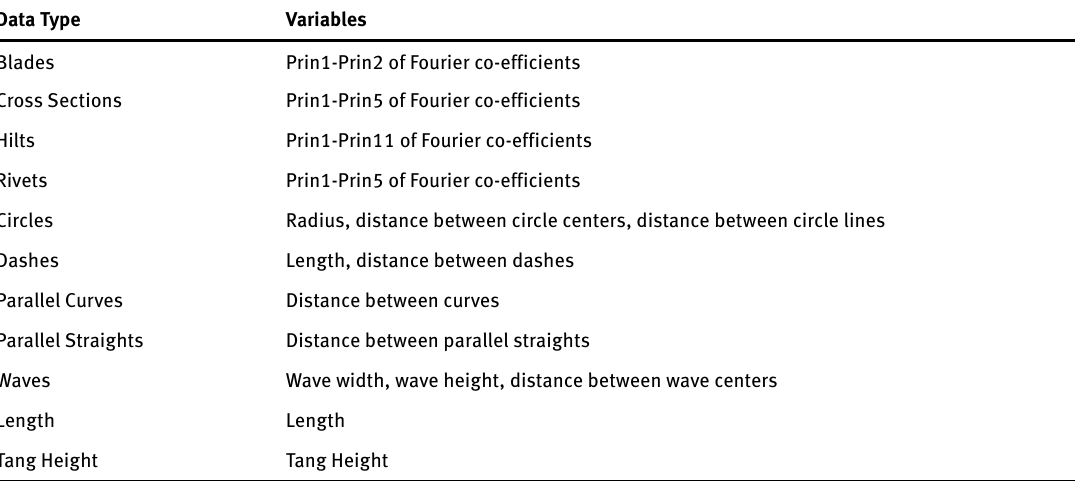
Table 1. Variables measured for each type of decoration. Cross section data shows the number of principle components that make up 95% of the